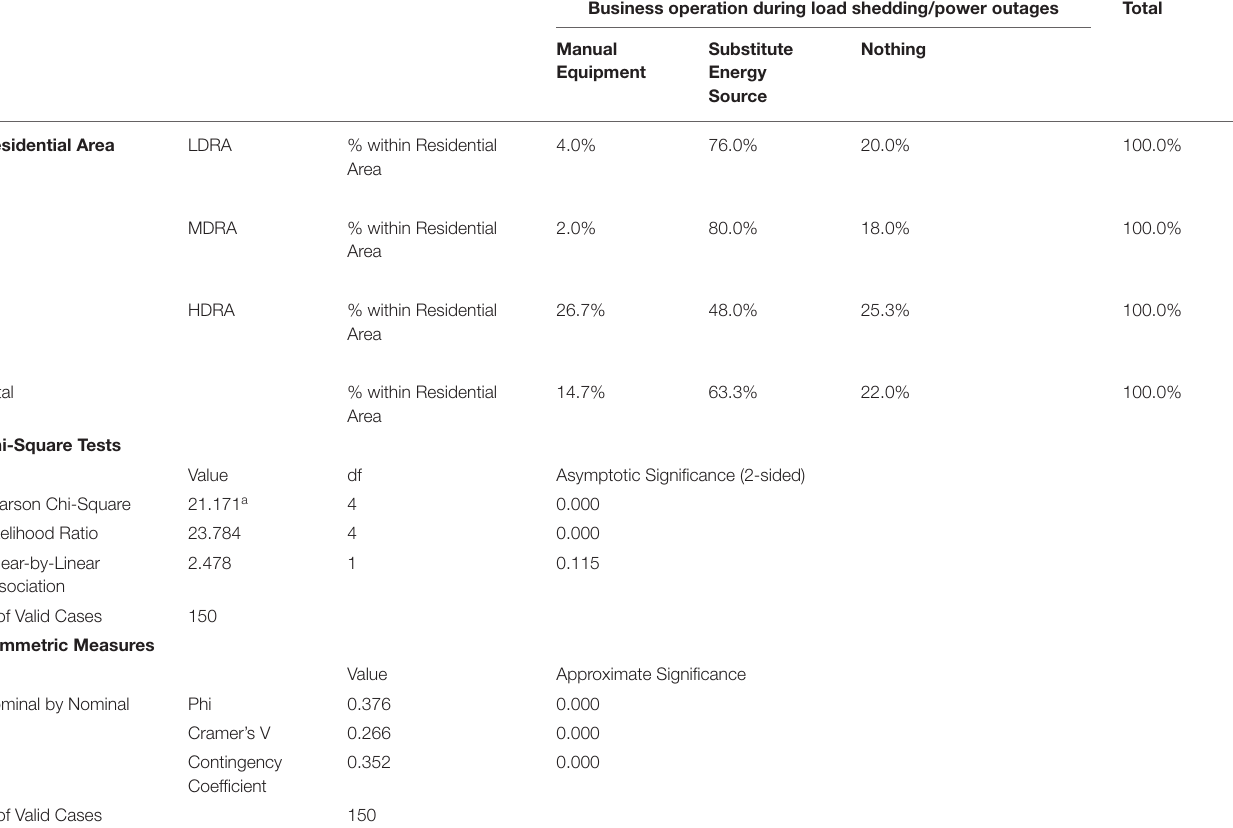
TABLE 5 | Association between residential area and business operation during load shedding.